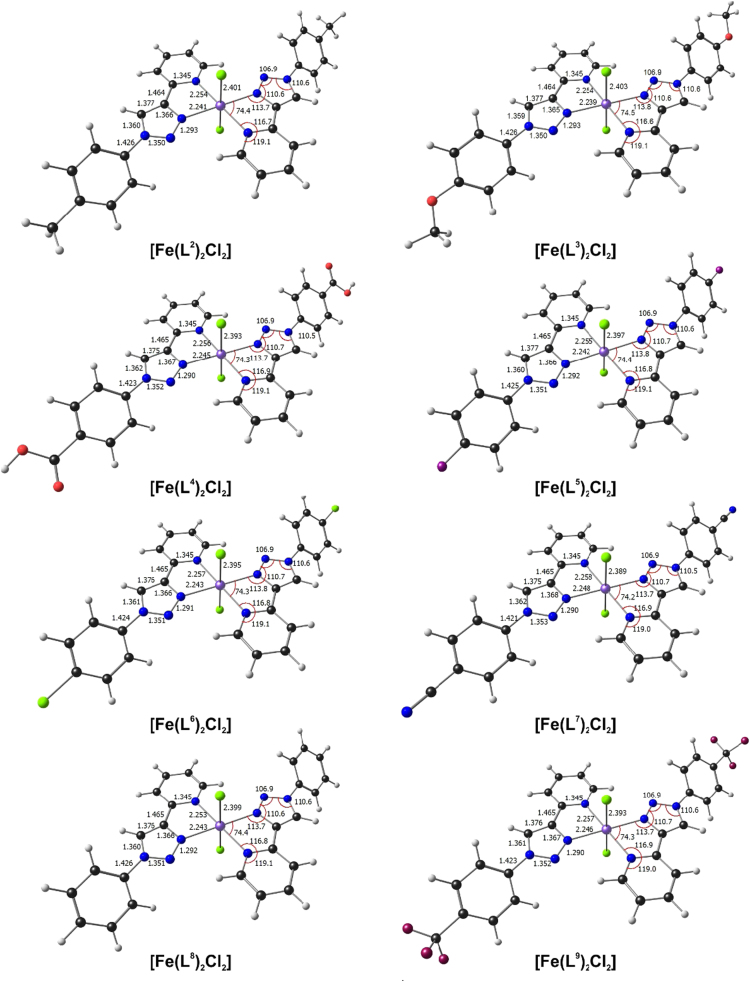
B3LYP calculated optimized geometries of the lowest energy trans-trans-trans isomer of [FeII(Ln)2Cl2]. R = CH3 (L2) [3], OCH3 (L3), COOH (L4), F (L5), Cl (L6), CN (L7), H (L8) [1] and CF3 (L9). Colour code of atoms (online version): Fe (purple), Cl (green), F (maroon), O (red), N (blue), C (black), H (white).